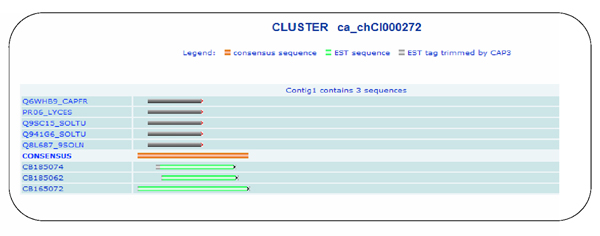
A screenshot of the graphical organization of a cluster. Windows reporting the length of the assembled contig (line in orange), the alignment of the ESTs that build the contig (in green) and the regions of the contig involved in blast matches (in dark grey). In light grey trimmed regions are reported too.